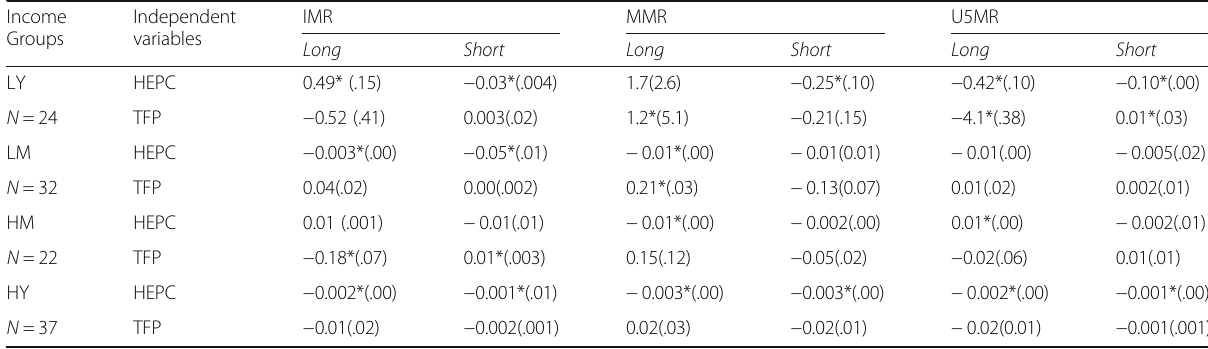
Table 8 Mean group estimation ARDL model (with total factor productivity) Income